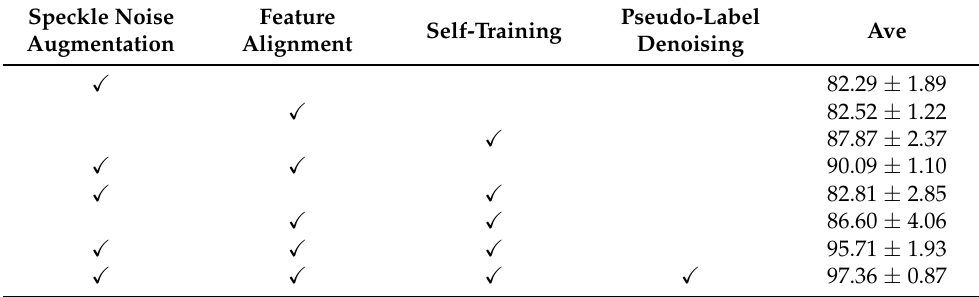
Table 11. Ablation analysis